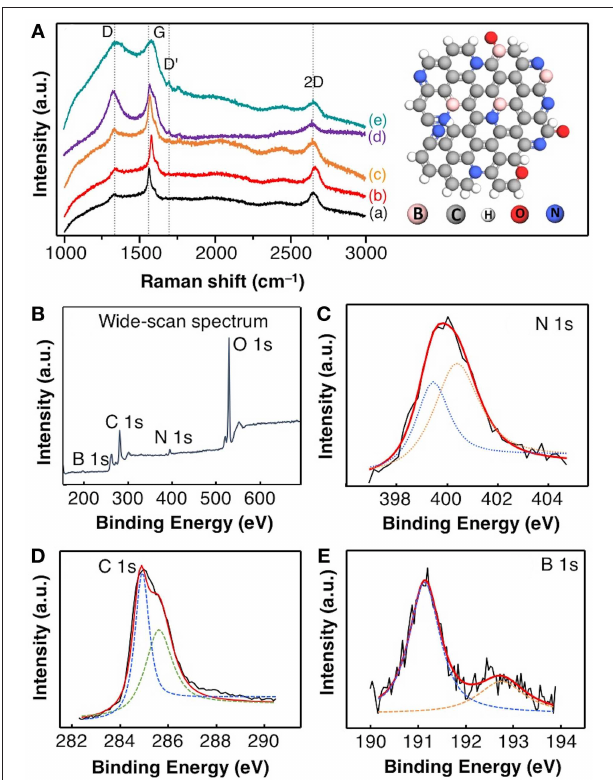
FIGURE 3 | (A) The Raman spectra of (a) pristine graphite and NB-GNs synthesized by SLPE in the presence of (b) 5mM, (c) 2.5mM, (d) 1mM, and (e) 0.1mM NaBPh 4 in 0.77mol ACN. The high-resolution XPS analysis of individual deconvolution core-level (B) wide-scan, (C) N 1s, (D) C 1s, and (E) B 1s spectra of NB-GNs (0.1mM NaBPh 4 in 0.77mol ACN). The insert (on top) represents the ball-stick model of N and B co-doped graphene based on Raman spectroscopy and XPS